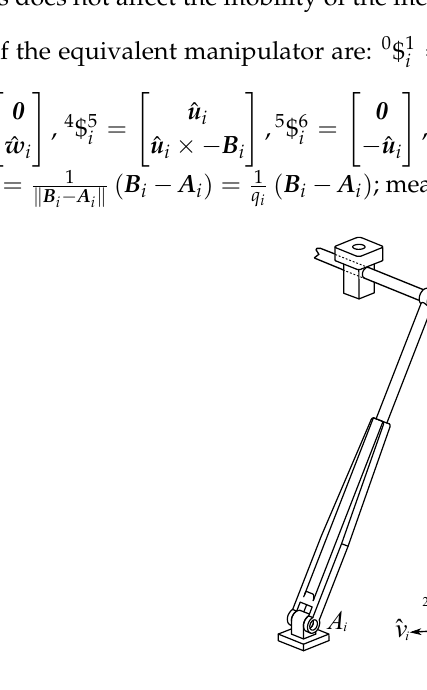
Figure 6. Infinitesimal screws of a